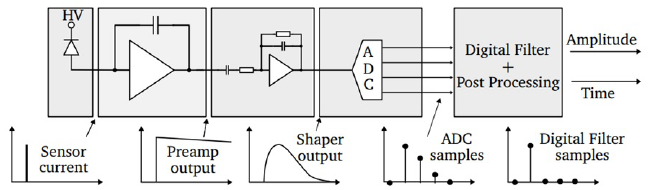
Figure 2: Block diagram of the proposed readout scheme